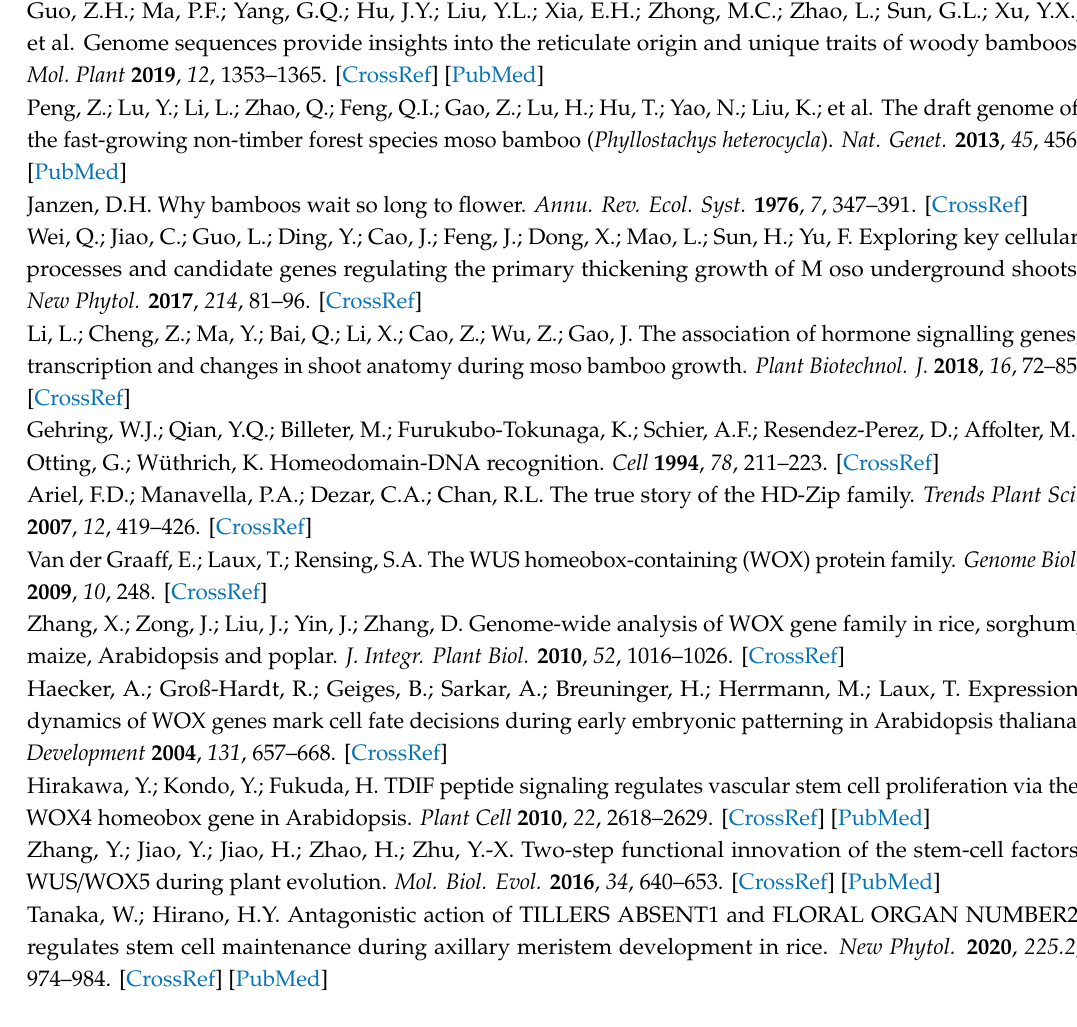
Figure S1: The Maximum Likelihood tree of WOXs from dicot and monocot; Figure S2: The alignment of WOX13s amino acid sequences; Figure S3: The alignment of the genome sequences of Bambusoideae WOX4s; Figure S4: The alignment of the genome sequences of Bambusoideae WOX5s; Figure S5: Sliding-window of the WOX11 / 12s; Figure S6 Sliding-window of the paralogous genes in the WUS clade; Figure S7: Sliding-window of the orthologous genes in the WUS clade; Figure S8: The conservative cis-element distribution in the promoters of Bambusoideae WOX8(a), WOX9(b), Tables S1: The informations of Bambusoideae WOXs; Tables S2: The informations of dicot and monocot WOXs used in this study; Table S3: The Ka / Ks ratio of dicot and monocot WOXs in sub-group; Tables S4: The Ka / Ks ratio of Bambusoideae WOXs in sub-group; Table S5: The cis-elements predicted in the promoter of Bambusoideae WOXs, Dataset S1: Polypeptides used to construct phylogenetic tree of AtWOXs, PotriWOXs, OsWOXs, ZmWOXs, BradiWOXs, and